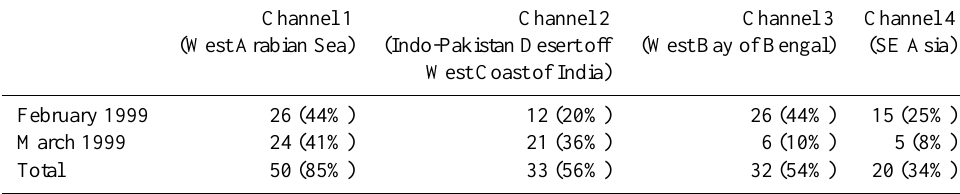
Table 5. Number of days (and relative frequency in %) that each of the four flow channels was present over the north Indian Ocean area during February and March 1999 (from Verver et al., 2001, copyright 2001 by the American Geophysical Union, reproduced with